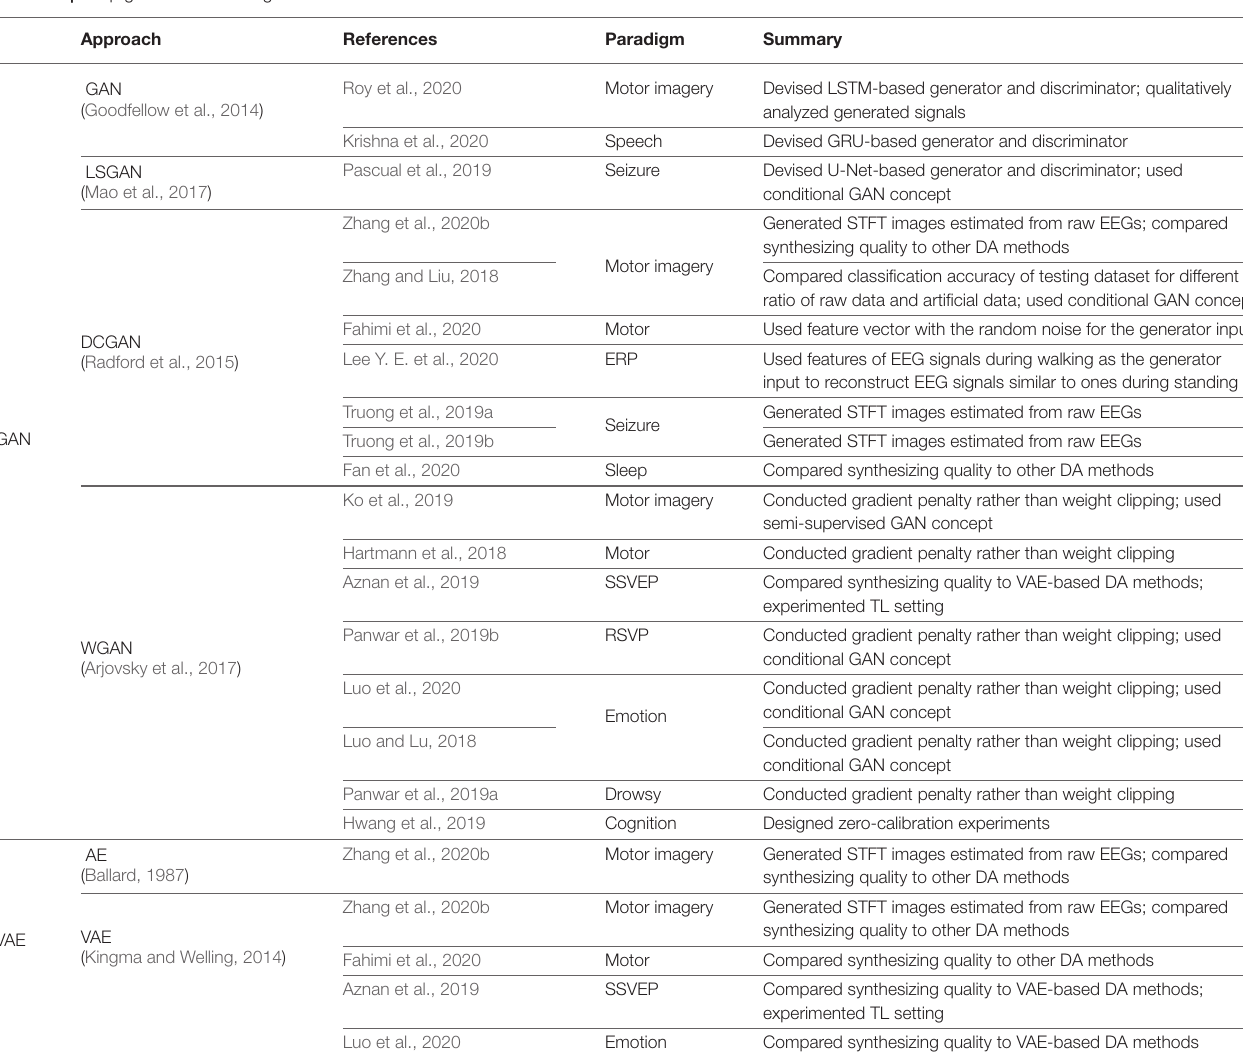
TABLE 2 | Deep generative data augmentation